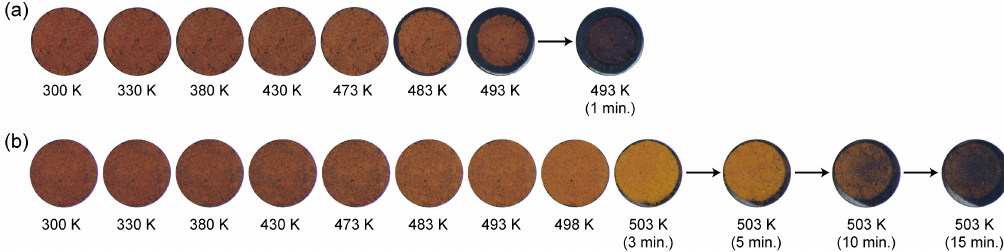
Figure 2. Temperature-dependent optical microscope images of grinding samples of 1·PF 6 ( a ) and 1·AsF 6 ( b ) deposited on a heating stage. Unless otherwise noted, after increasing the sample temperature at each target point, the sample was held for 5 min, and then an image was taken at each temperature.